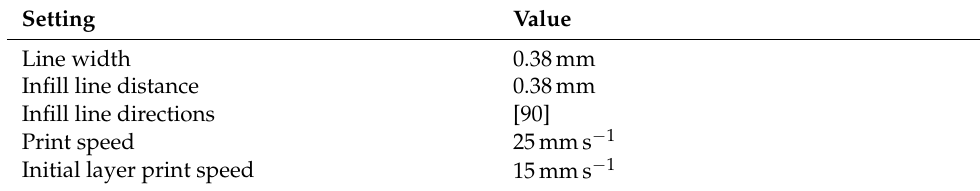
Table 9. Slicer settings 0° orientation.